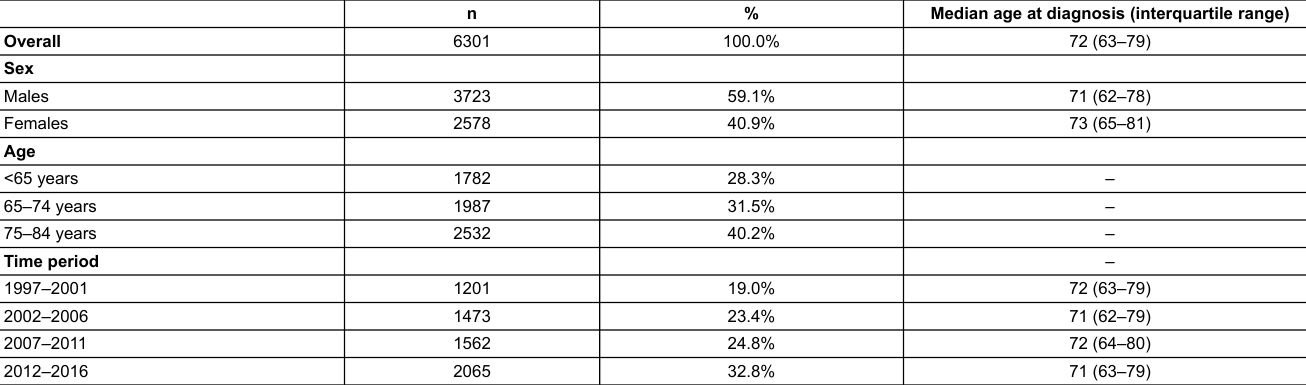
Table 1: Patient characteristics of chronic lymphocytic leukaemia / small lymphocytic lymphoma cases reported to Swiss cancer registries, 1997–2016. n